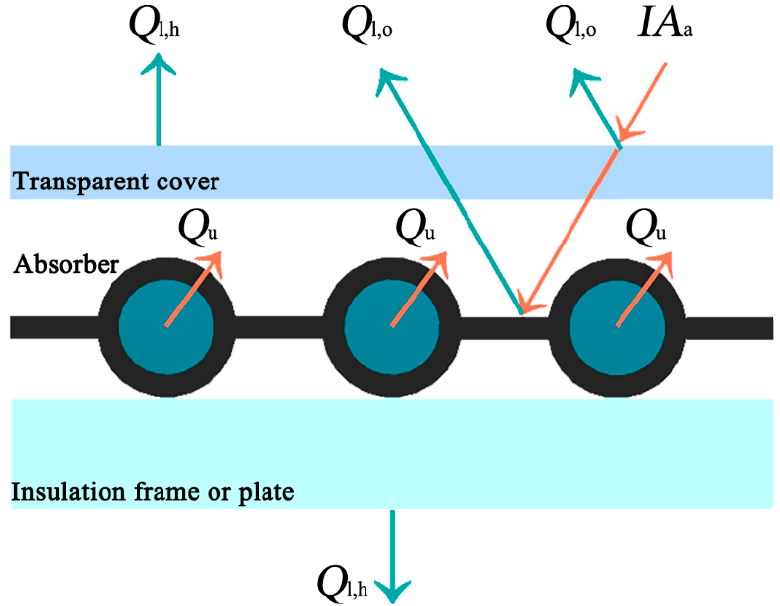
Figure 4. Energy conservation relationship of VTBC solar collectors. Under unsteady-state conditions, such as early in the morning, the absorber tempera- ture ( T abs ) increases. All components of the collector continuously absorb heat and store energy. When the sun sets in the evening, T abs drops, and the components of the collector continuously release heat and energy. Under steady-state conditions, Q s is 0. Therefore, for the convenience of analysis, unsteady-state conditions are not considered in this study. At this point, Q u can be expressed by Equation (2).